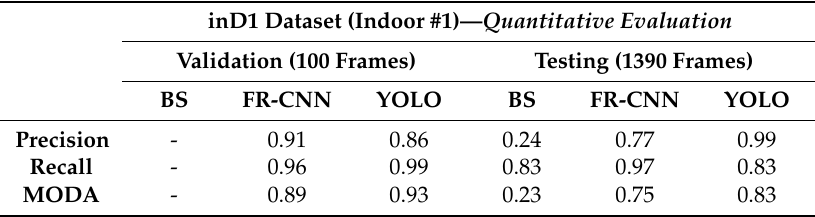
Table 3. Quantitative results from the indoor dataset